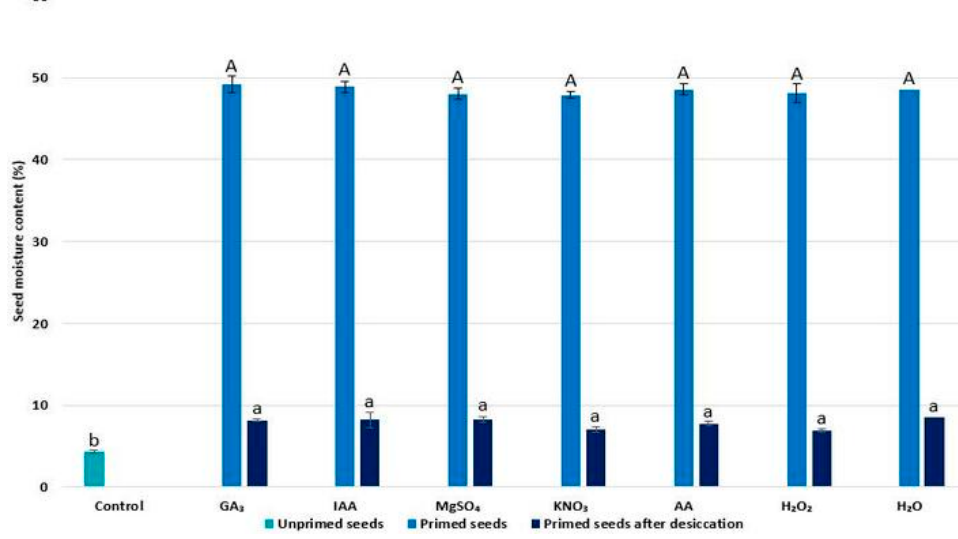
Figure 1. The moisture content of radish ( R . sativus ) seeds after priming for 24 h and after desiccation of primed seeds for 48 h prior to germination; control—unprimed seeds. The values represent the means of five replicates ± standard error. Small alphabetical letters (a,b) above the means show the differences ( p ≤ 0.05) between primed seeds after desiccation and unprimed seeds, while capital alphabetical letters reveal the differences ( p ≤ 0.05) between seeds immediately after 24 h of application of different priming agents by Tukey’s test.